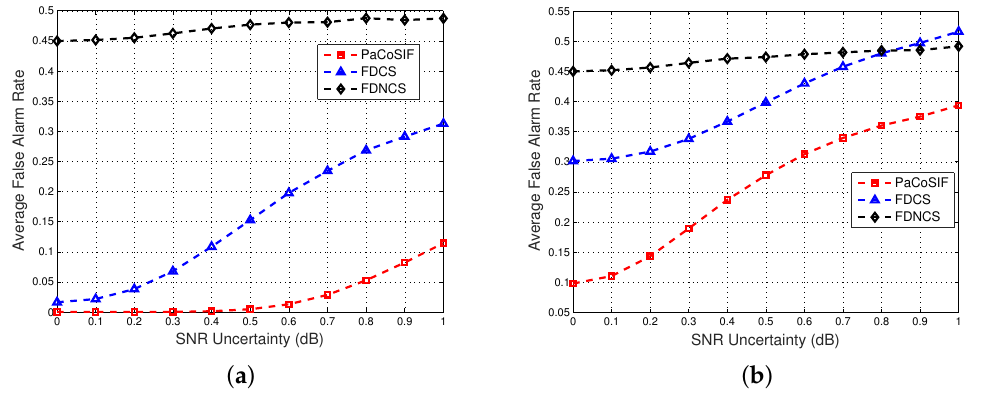
Figure 10. The impact of noise uncertainty upon the mean false alarm rate. ( a ) ∆ ρ = 4 dB; ( b ) ∆ ρ = − 4 dB.